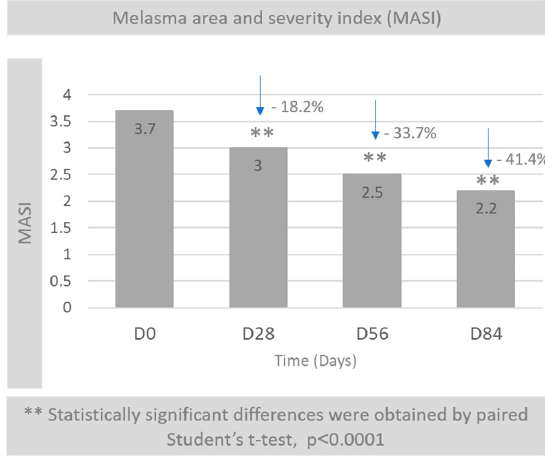
Figure 1. MASI score at D0, D28, D56 and D84.